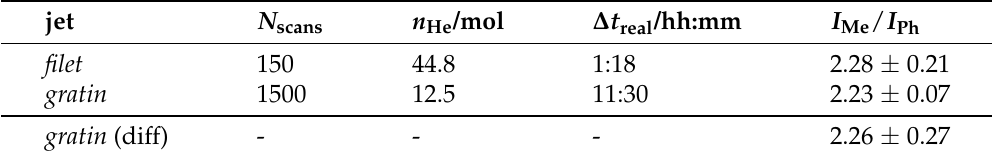
Table 4. Comparison of the performance of filet and gratin jet, using example spectra of MeOH+2FAP ( N scans : number of co-added scans per spectrum; n He : amount of He used for recording the spectra; ∆ t real : real-time needed to record the spectra; I Me / I Ph : intensity ratio of dimer donor OH stretch signals of Me and Ph sided dimer; filet jet spectrum: green trace in Figure 10a); gratin jet spectrum: red trace in Figure 8; gratin jet difference spectrum: purple trace in Figure 9).